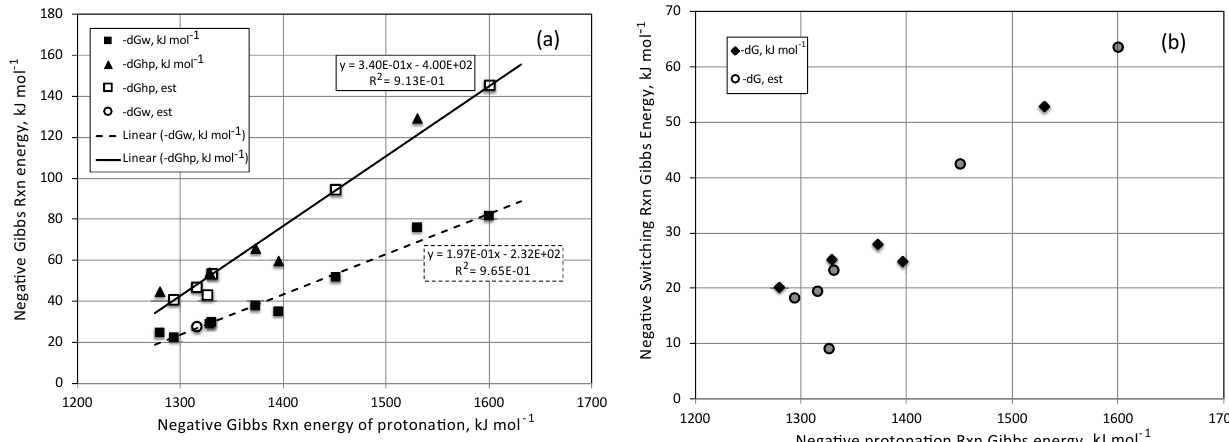
Figure 2. Relationship between the negative ion-protonation reaction Gibbs energy, − (cid:49)G o energy, − (cid:49)G o , and ion-H 2 O 2 cluster reaction Gibbs energy, − (cid:49)G o R1 − (cid:49)G o . Reactions (R1)–(R4) refer to reactions introduced in the text with A = H 2 O 2 . Filled symbols denote measured values and open R3 symbols indicate estimated values. The lines indicate least square linear regression fits with the regression constants and coefficient of determination given in the respective boxes. The use of negative values of the Gibbs energy of reaction follows NIST (Bartmess, 2016)